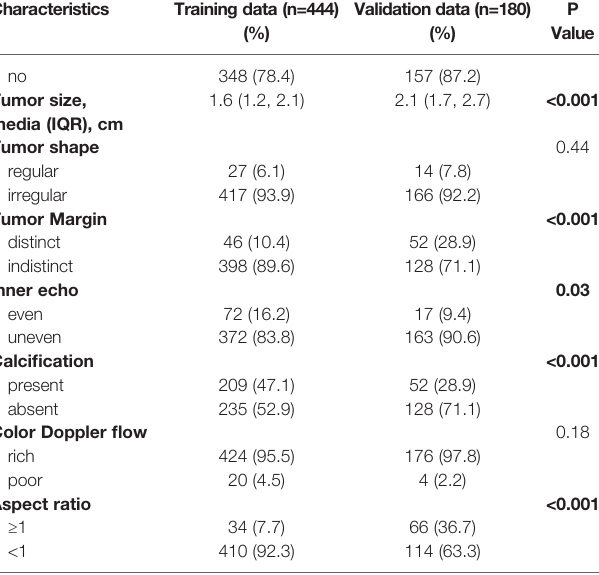
TABLE 1 | Participant baseline characteristics in two